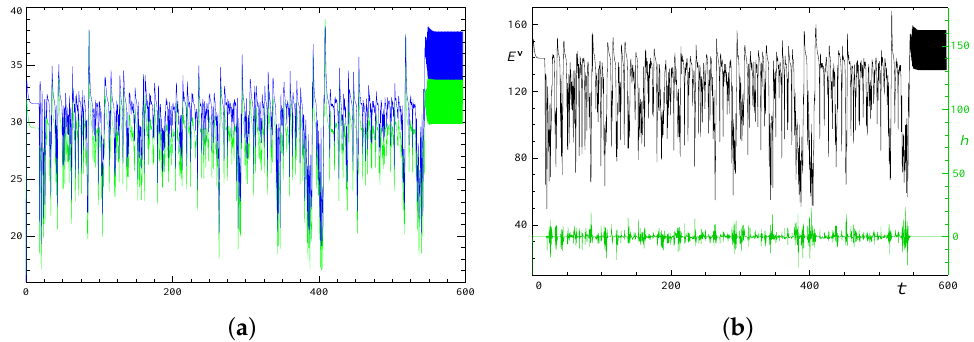
Figure 16. Temporal behaviour of the magnetic Reynolds number estimates Rm (cid:48) Rm (cid:48) (blue line), (a), and of the kinetic helicity (green line, right vertical axis) together with the kinetic 3 energy (black line, left vertical axis) for reference, (b), in run 3 x 1.2. The temporal behaviour of the coefficients Re ˆ v 1 Figure 17 for 0 ≤ t ≤ 600, is typical for individual harmonics in the triple-periodic runs. Plots of the temporal power spectra Figure 18a,b of the two coefficients, computed in